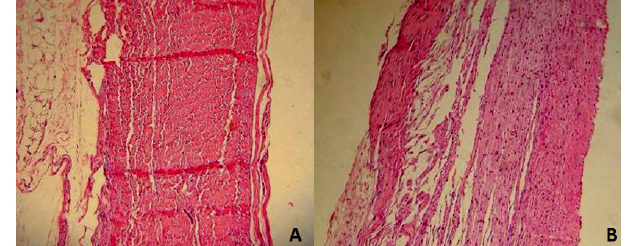
Fig. 3 - Normal histologic study. A) Bovine pericardium; B) porcine aortic leaflets.